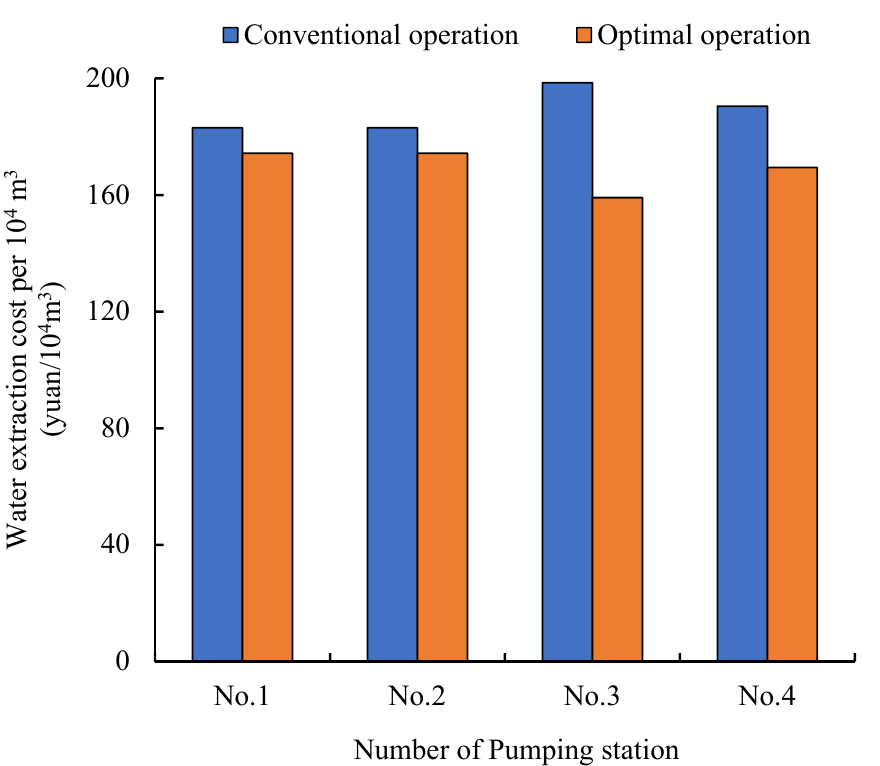
Figure 4. Optimal operation efficiency of water pumping costs compared with conventional operation of each pumping station.